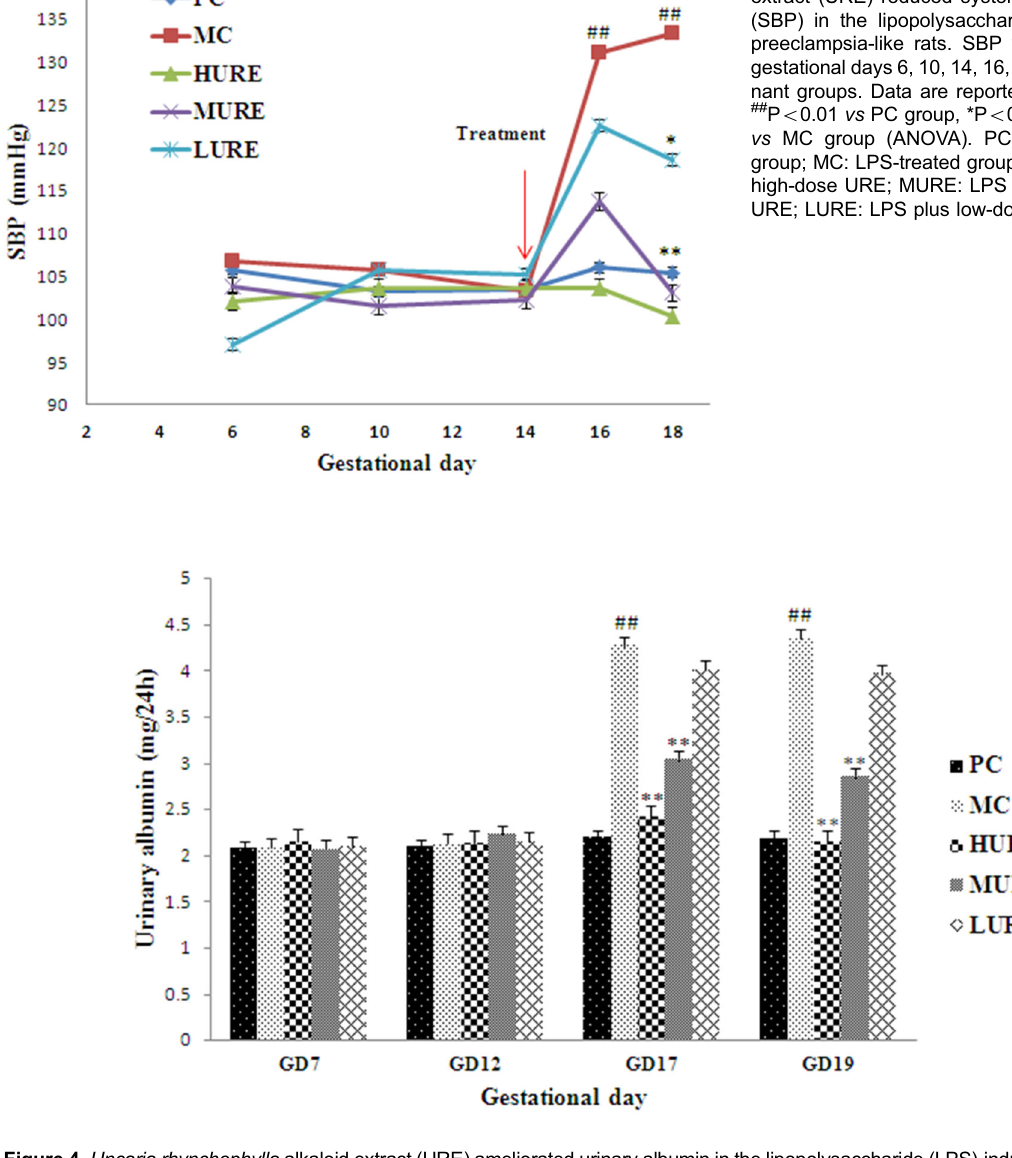
Figure 3. Uncaria rhynchophylla alkaloid extract (URE) reduced systolic blood pressures (SBP) in the lipopolysaccharide (LPS)-induced preeclampsia-like rats. SBP was measured on gestational days 6, 10, 14, 16, and 18 in the preg- nant groups. Data are reported as means ± SE.